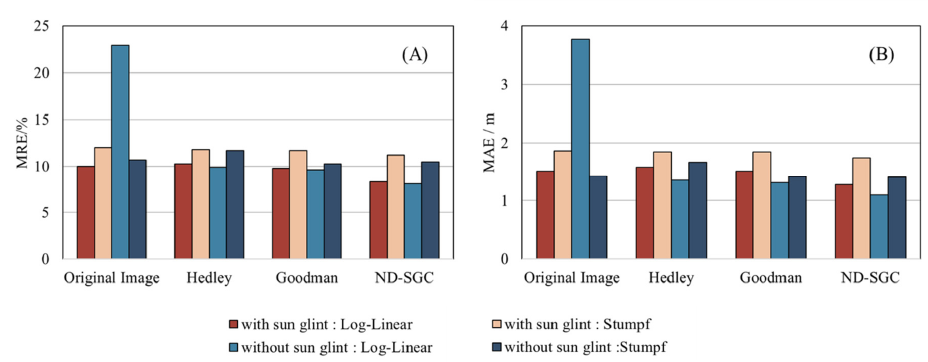
Figure 9. At Dongdao Island (11–20 m), the MRE, MAE of the two bathymetric inversion models on glint pixels and glint ‐ free pixels. ( A ) MRE; ( B ) MAE. Figure 10 shows the evaluation indexes and scatter plots of the bathymetric inversion ac ‐ curacy on the sun glint pixels and sun glint ‐ free pixels in the Tiexian Jiao. As can be seen in Figure 10, all three sun glint correction models improved the bathymetric inversion accu ‐ racy on the sun glint pixels, with the ND ‐ SGC method having the most obvious positive impact on the bathymetric inversion. The ND ‐ SGC method resulted in a maximum reduc ‐ tion of 4.4% in MRE and 0.38 m in MAE for both bathymetric inversion models.